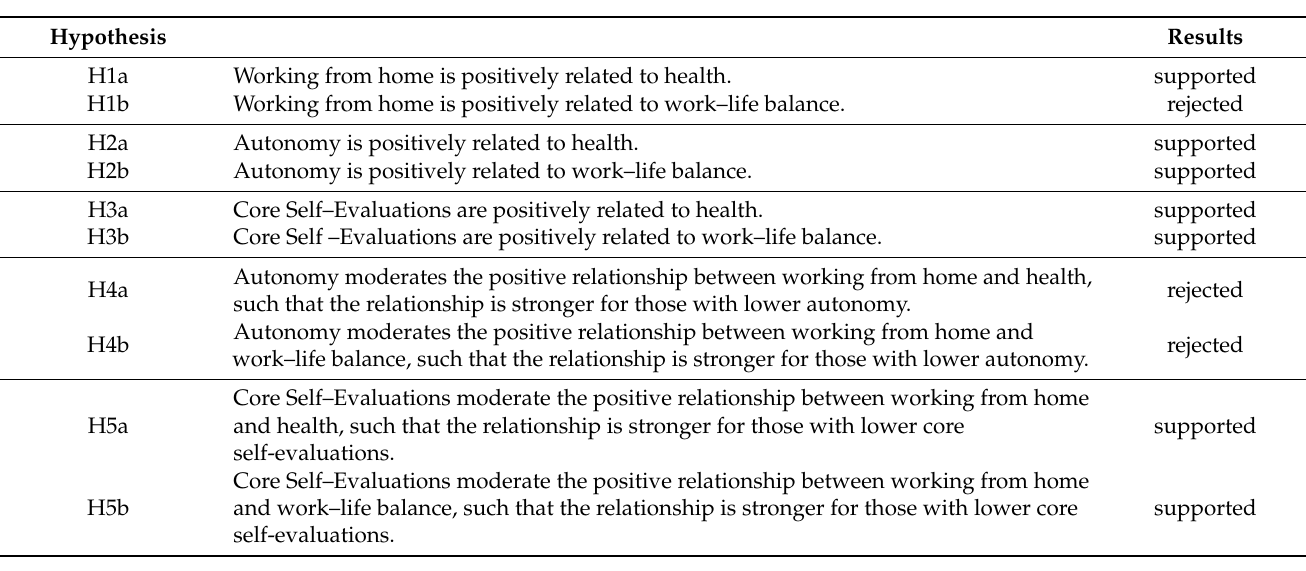
Figure 3. Plot of the interaction between working from home intensity and autonomy (3a), and working from home intensity and core self–evaluations (3b) on work-life balance. ** p < 0.01. Table 3. Summary of study hypotheses and